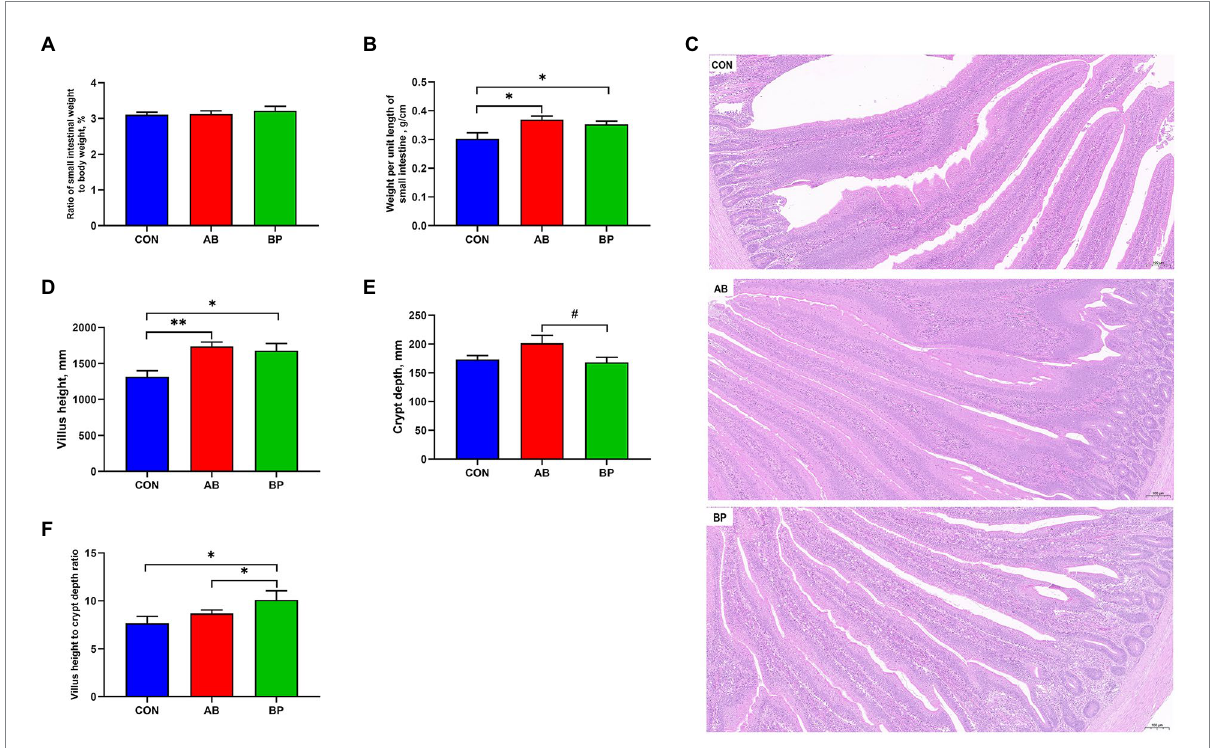
FIGURE 2 Effects of dietary supplemented with Bopu powder on intestinal development in broiler chickens. (A) Ratio of small intestinal weight to body weight; (B) Weight per until length of small intestine; (C) Representative images (×100) were stained with hematoxylin and eosin; (D) Villus height; (E) Crypt depth; and (F) Villus height to crypt depth ratio. CON group, broiler chickens fed a basal diet; AB group, broiler chickens fed a basal diet supplemented with 50 mg/kg aureomycin; and BP group, broiler chickens fed a basal diet supplemented with 40 mg/kg Bopu powder containing protopine and allocryptopine. Values are mean ± standard error ( n = 6). # 0.05 ≤ p < 0.10, * p < 0.05, ** p <